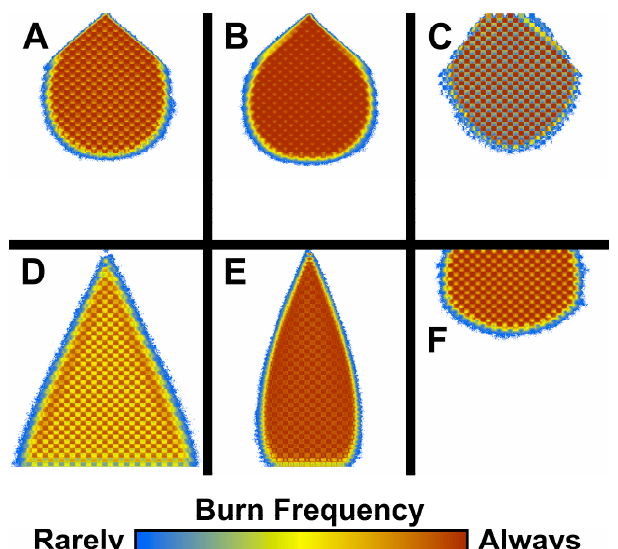
Figure 5. Mean burn frequencies produced by 100 replicates of six model variants: ( A ) the baseline model, ( B ) increased influence of proximity to fire, ( C ) increased influence of fuel flammability, ( D ) longer ember distances, ( E ) enhanced wind influence, ( F ) diminished wind influence. The checker- board patterns derive from the model’s flammability map, which was made up from alternating blocks of low and high flammability fuels.